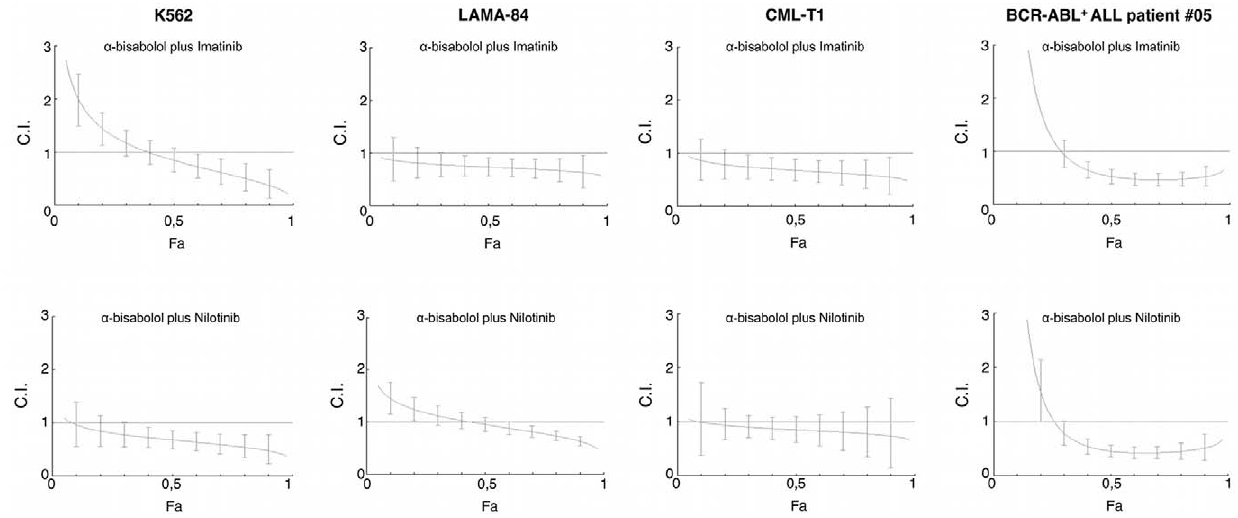
Figure 3. Fa-CI plots of interaction between a -bisabolol and TKIs. a -bisabolol plus imatinib or nilotinib proved to be synergistic both in BCR- ABL + cell lines and primary leukemic cells (CI , 0.1=very strong synergism; 0.1–0.3=strong synergism; 0.3–0.7=synergism; 0.7–0.85=moderate synergism; 0.85–0.90=slight synergism).